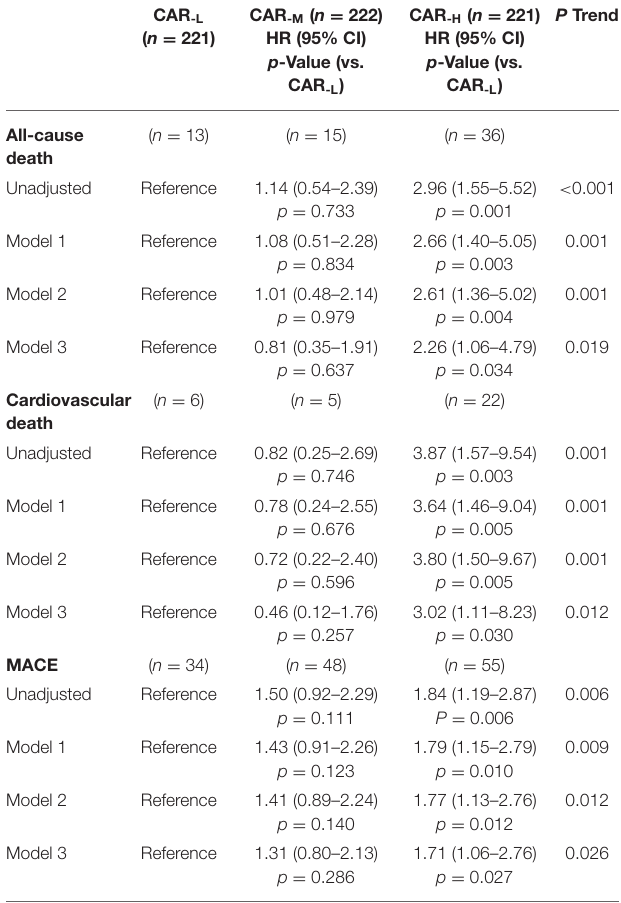
TABLE 2 | Cox proportional hazards analyses of clinical